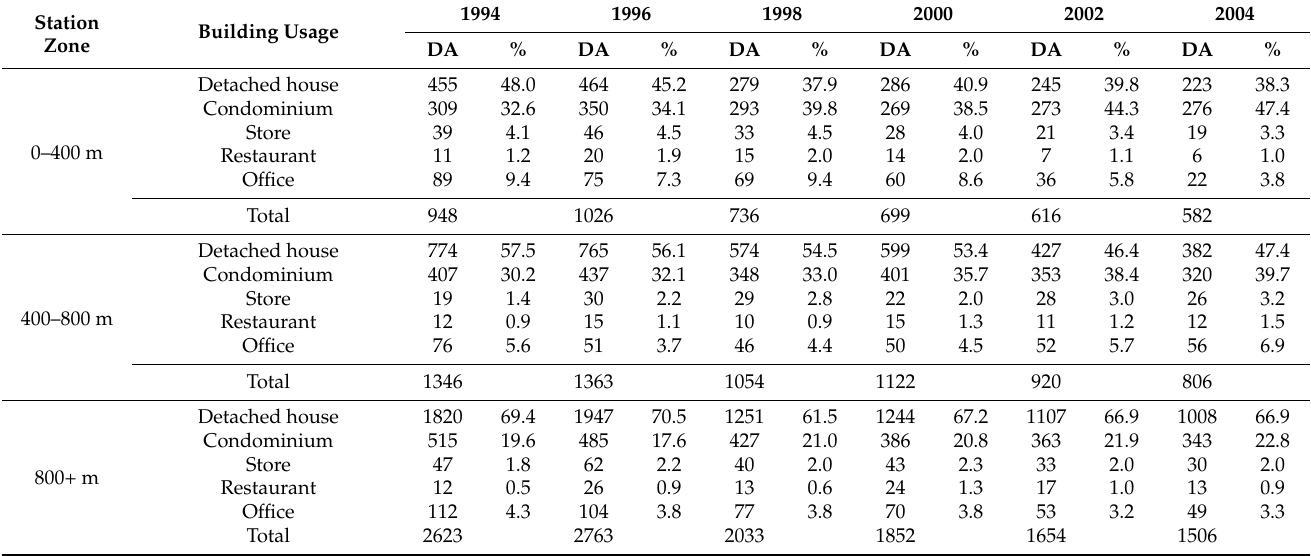
Table 5. Changes in development amount and distribution around station